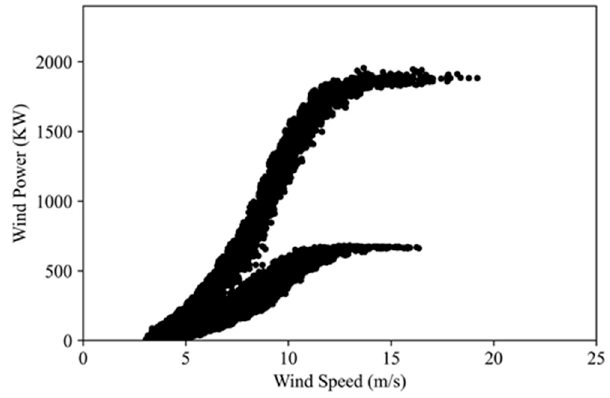
Figure 3. Abnormal data processed by I-Forest in interval detecting.